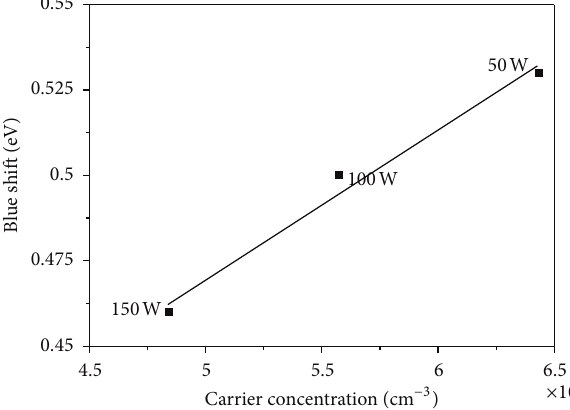
Figure 7: Blue shift of the GZO thin films as a function of carrier concentration.